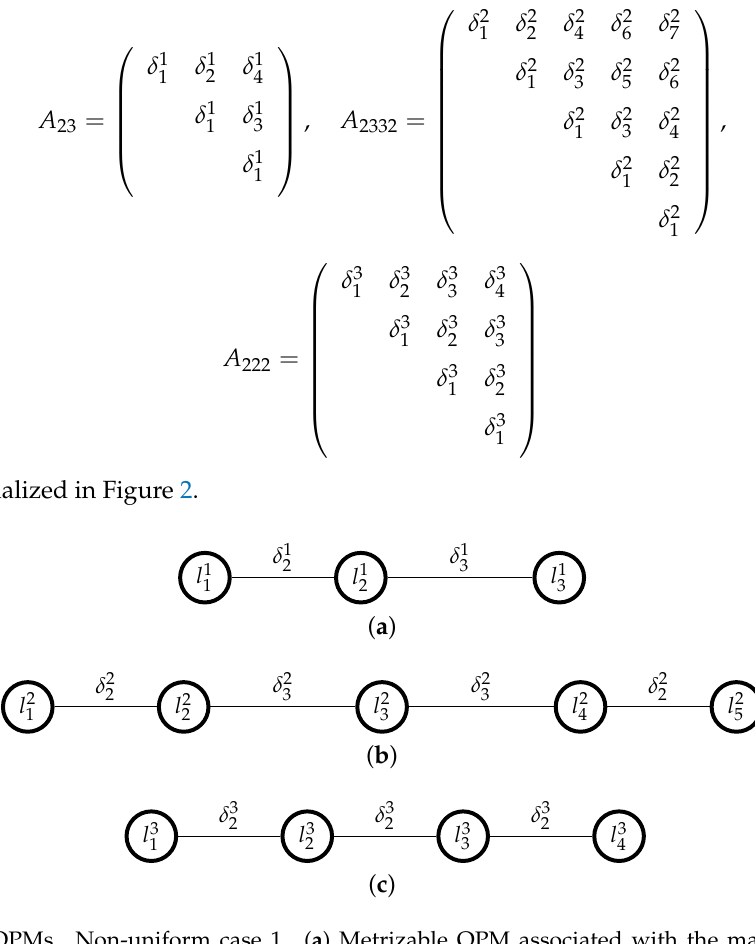
Figure 2. OPMs. Non-uniform case 1. ( a ) Metrizable OPM associated with the matrix A 23 ; ( b ) Metrizable OPM associated with the matrix A 2332 ; ( c ) Metrizable OPM associated with the matrix A 222